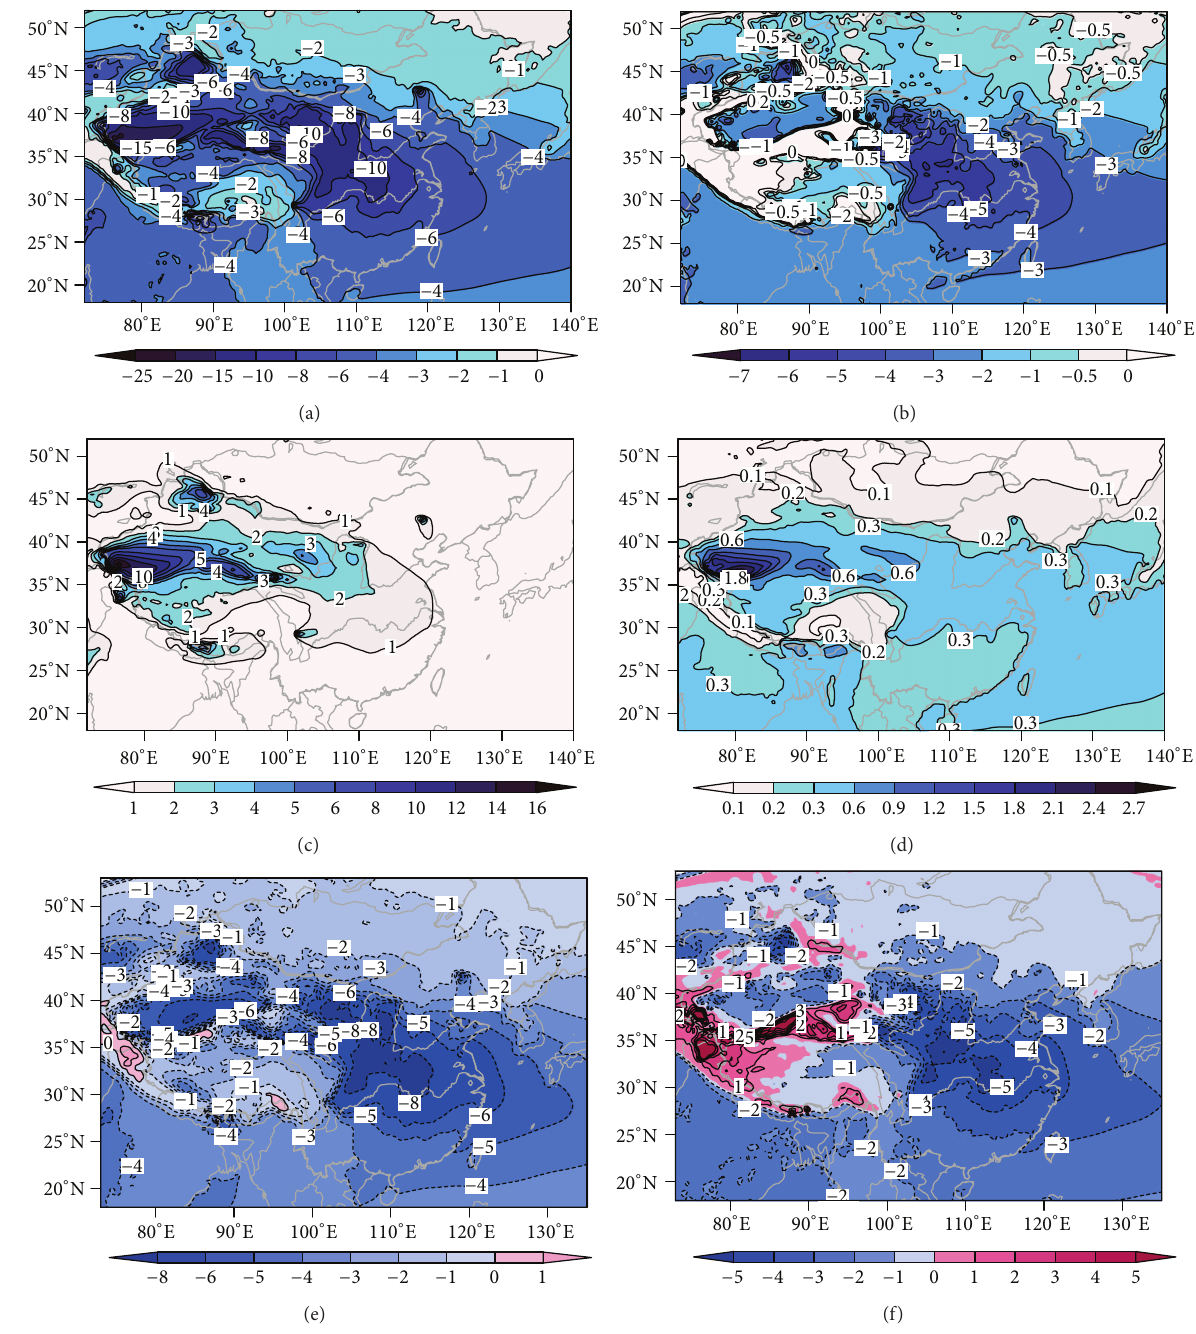
Figure 6: Simulated dust induced clear sky (a, b) SW, (c, d) LW, and (e, f) total radiation (SW plus LW, Wm −2 ) changes at (a, c, e) the surface and (b, d, f) the TOA, averaged in winter during 2000–2009